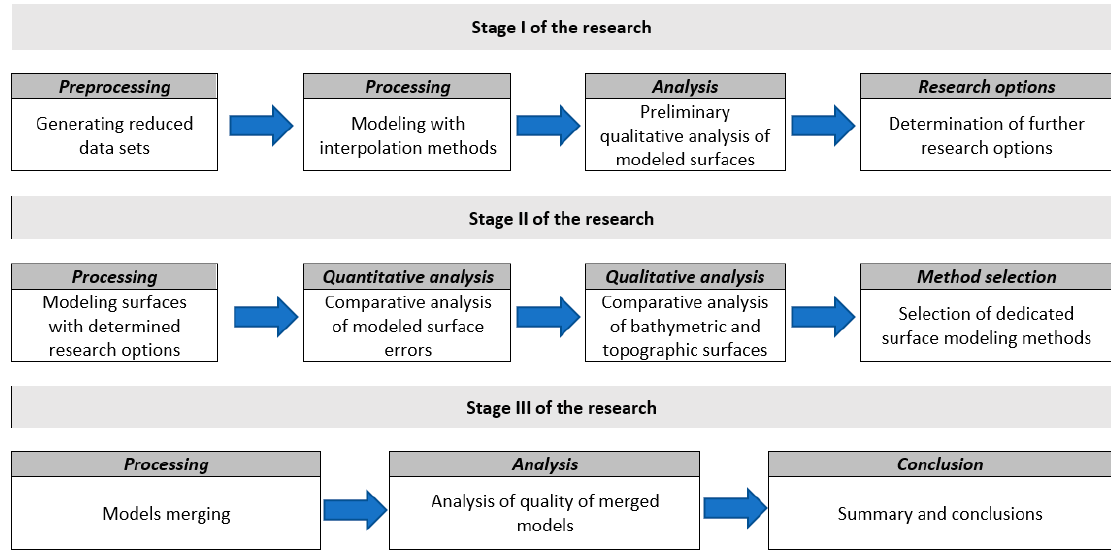
Figure 3. The research methodology.